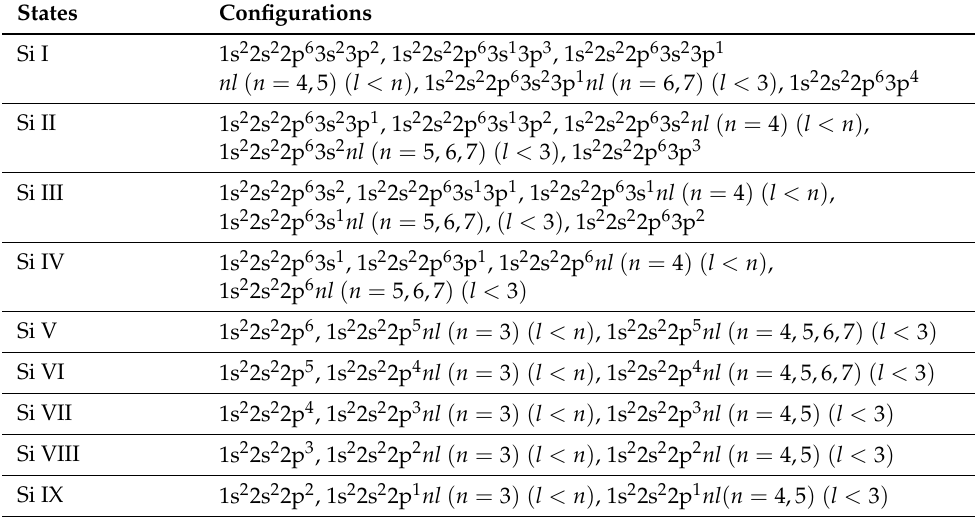
Table 2. The CR model for Si plasma includes all of the ground states from the neutral (Si I) through fully ionized charge states, and particularly, the important transitions from Si I through Si IX. Here, n and l are, respectively, the principal and orbital quantum numbers. The total levels in the CR is 1050.